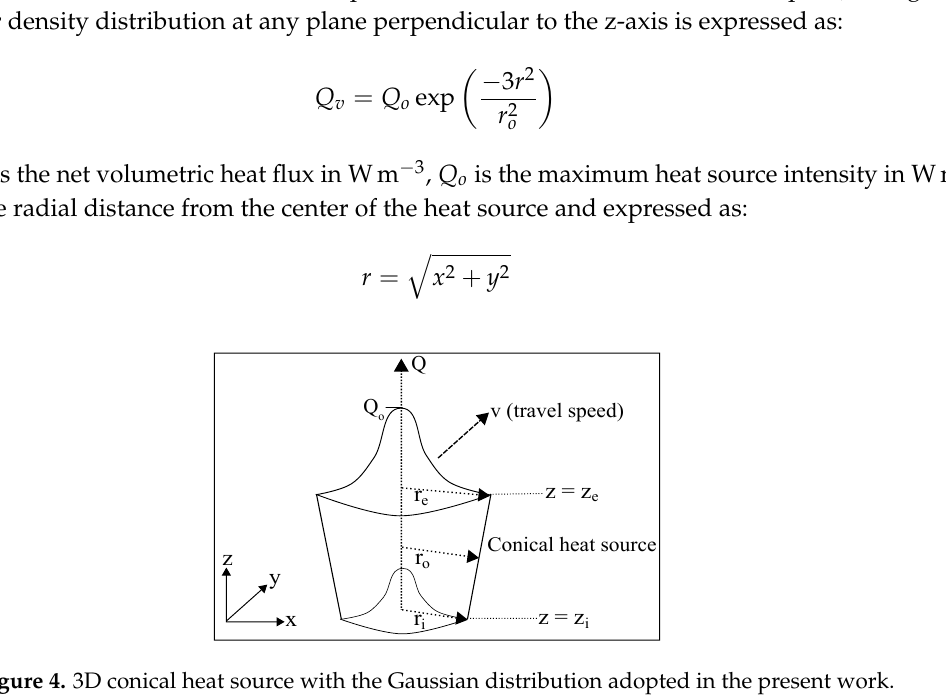
Figure 4. 3D conical heat source with the Gaussian distribution adopted in the present